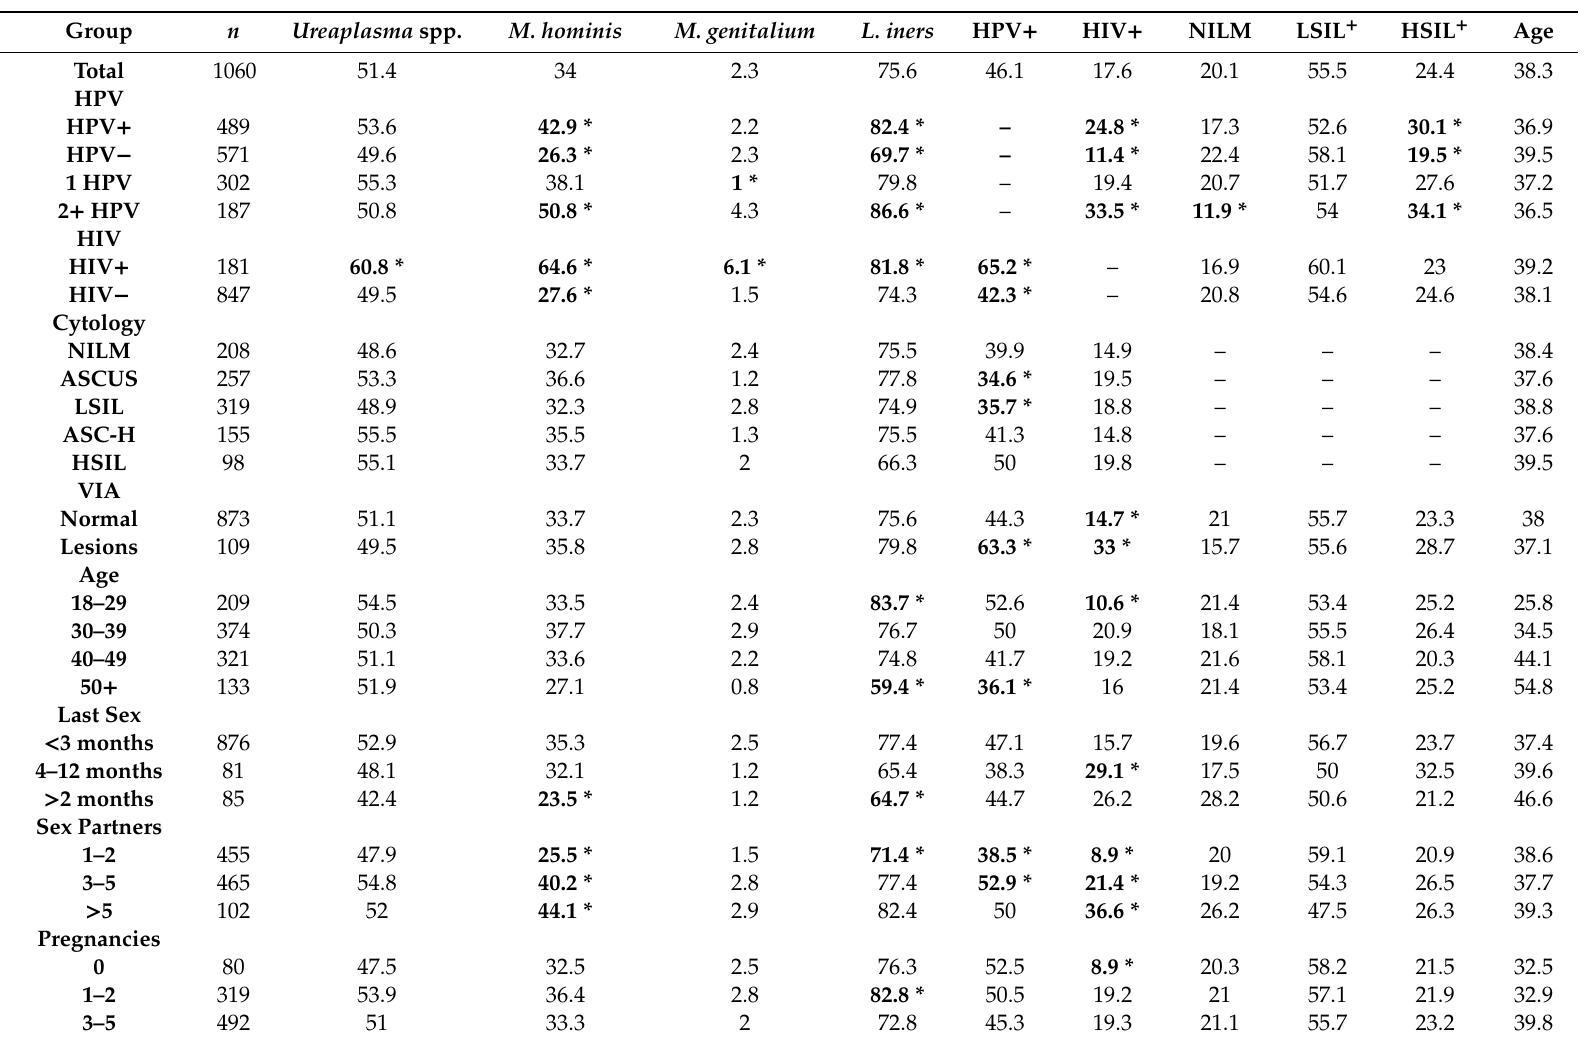
Table 1. Prevalence of Mycoplasma, HPV, HIV, and epidemiological